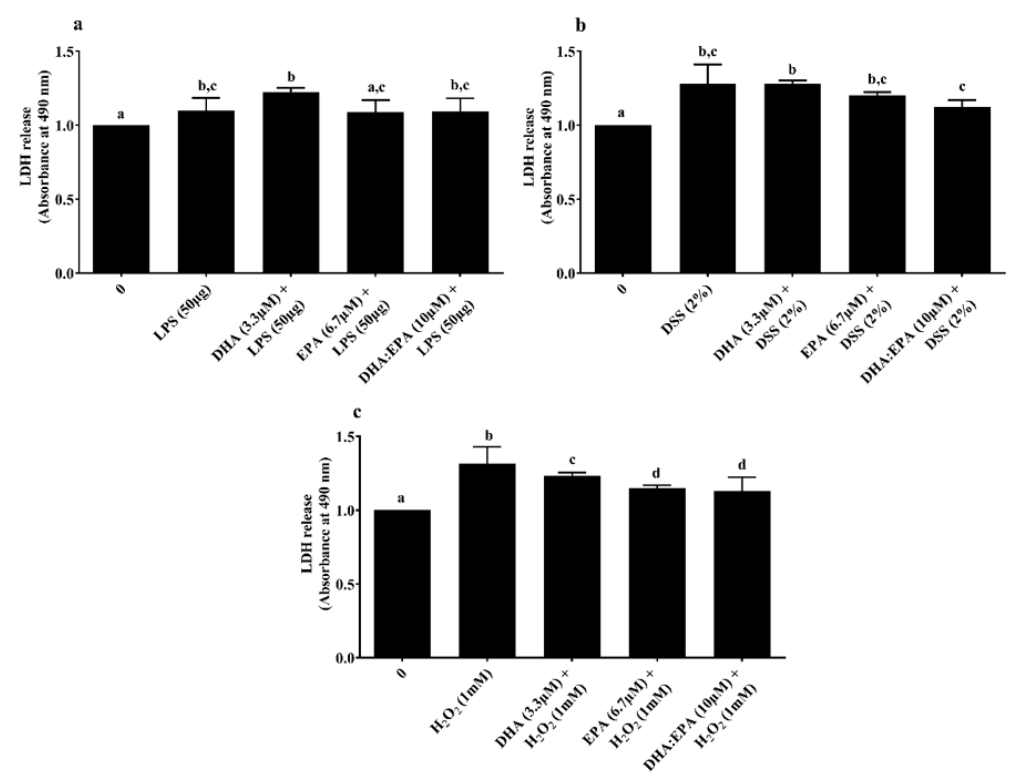
Figure 4. Effects of DHA (3.3 μ M), EPA (6.7 μ M) and DHA:EPA (1:2; 10 μ M) pre-treatment (24 h) on the membrane integrity of IPEC-J2 cells challenged by ( a ) LPS (50 or 100 μ g/mL) for 24 h; ( b ) DSS (2%) for 24 h and ( c ) H 2 O 2 (1 mM) for 1 h. Data are presented as mean ± SEM ( n = 3, one-way ANOVA). Statistically significant differences among the treatments are denoted by different letters (a, b, c, d), where p < 0.05.